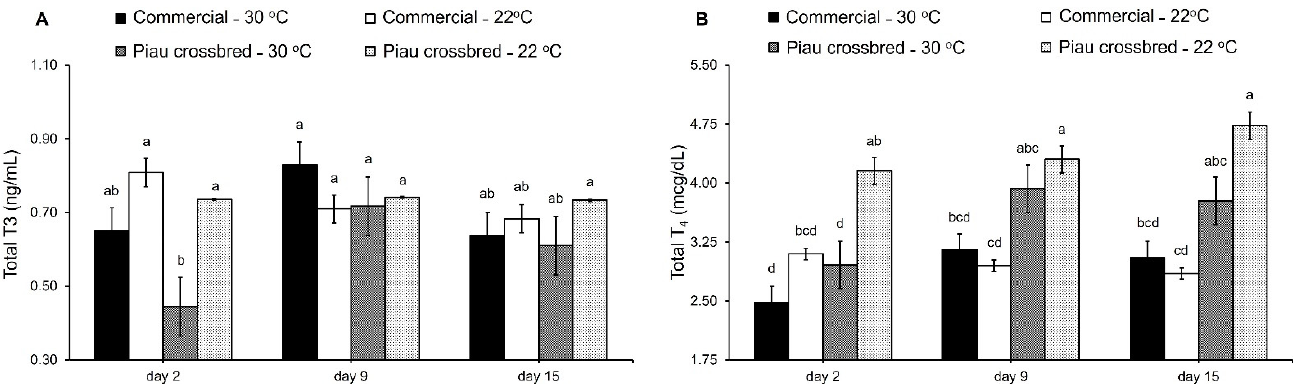
Figure 2. Serum triiodothyronine ( A ) and thyroxine ( B ) concentrations of commercial and Piau crossbred (Brazilian Piau purebred sires × commercial dams) pigs as a function of ambient temperature. Each vertical bar is the standard error of the mean. Within each graphic, least square means with different letters differ ( p < 0.05).